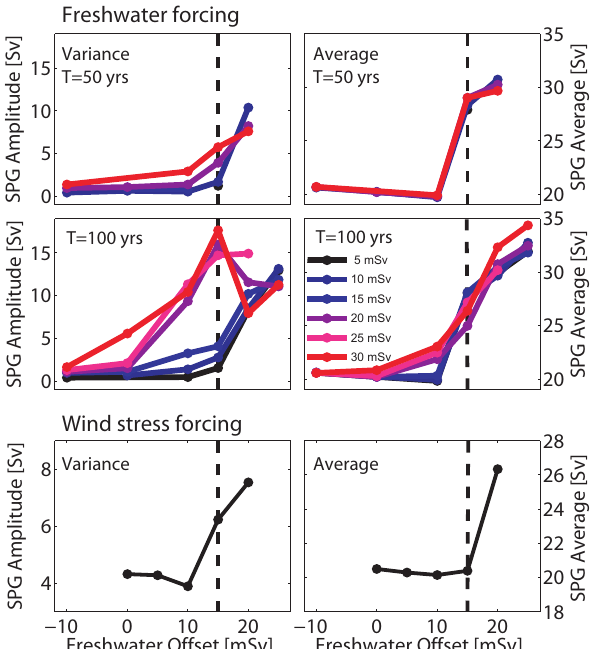
Fig. 5. Upper and middle panels: mean SPG strength and its vari- ability for different constant off-set in surface freshwater flux. Dif- ferent lines correspond to the forcing amplitudes as denoted in the legend. Lower panels: Wind induced variability of the SPG for dif- ferent constant freshwater off-sets. The dashed vertical line marks the position of the equilibrium threshold at 15mSv (compare to Fig. 1). The amplitude of SPG variations increases when approach- ing the threshold for both time-varying freshwater and wind stress forcing. This is best seen for the 100yr period freshwater forcing, but still present on the shorter time scales (50yr period and wind stress forcing). Even close to the threshold the system’s response to NCEP wind stress variability is significantly smaller than its re- sponse to centennial scale freshwater variations. The lower panels have a different y-scale.